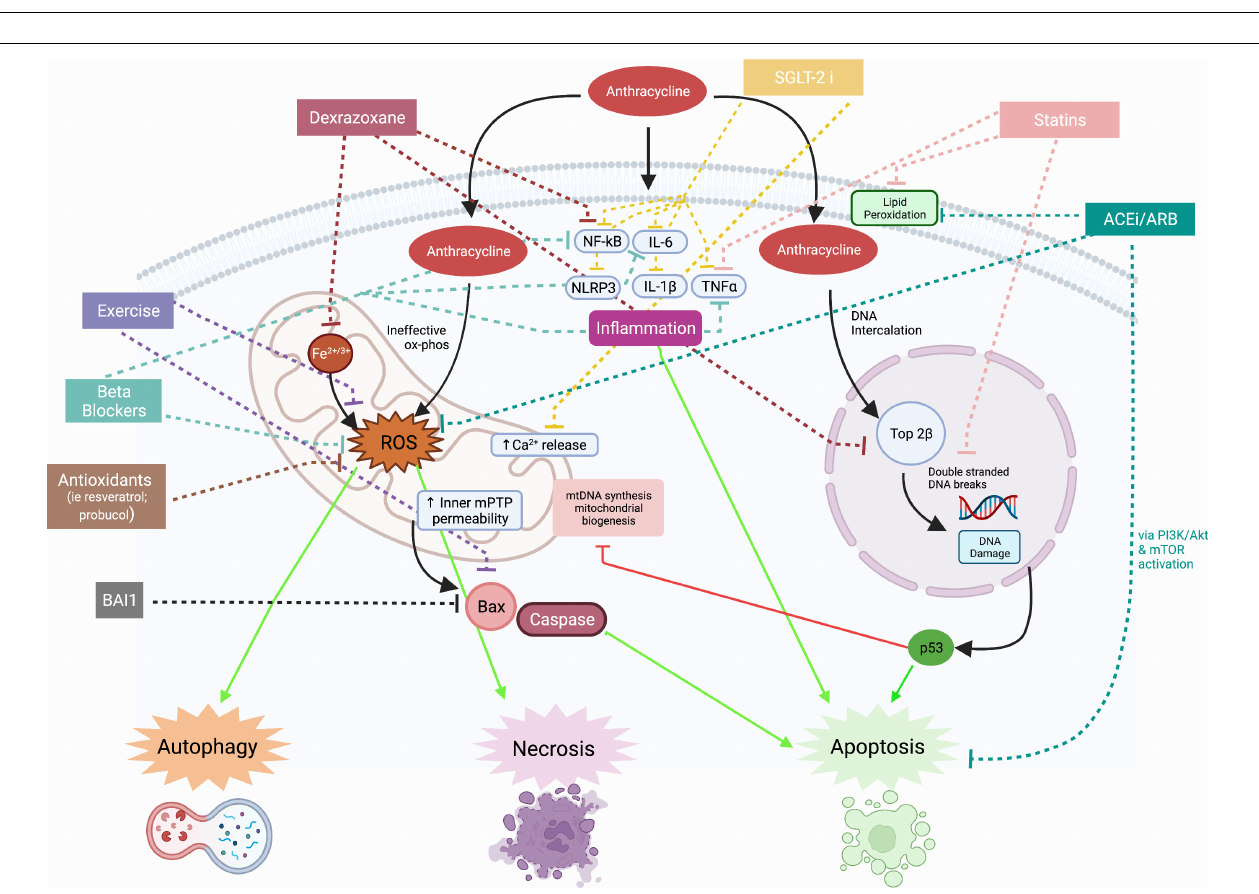
FIGURE 1 | Central illustration. Summary of anthracycline induced cardiotoxicity (AIC) and treatment options. AIC on a cellular level is mediated by cytoplasmic vacuolization, cardiac fibrosis, and myofibril loss and is associated with echocardiographic of decreased systolic function, increased diastolic dysfunction, and decreased global longitudinal strain. Potentially preventative and/or investigational therapies for AIC associated systolic dysfunction include dexrazoxane, neurohormonal pharmacologic therapy, and aerobic exercise. Moderate to end stage therapy considerations include cardiac resynchronization therapy, mechanical circulatory support, and orthotopic heart transplantation. Therapies such as stem cell therapy, gene therapy, and targeting of AIC-specific mechanisms (such as apoptosis, reactive oxygen species production, and inflammation) are under ongoing investigation. Created with BioRender.com.